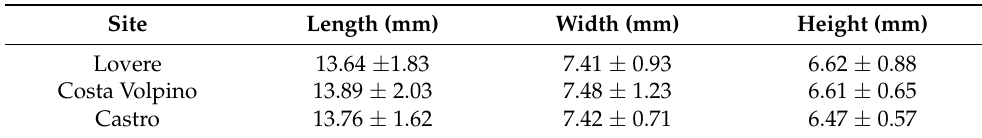
Table 2. Mean ( ± SD) biometric features (length, width, height) of D. polymorpha from the three sampling sites.